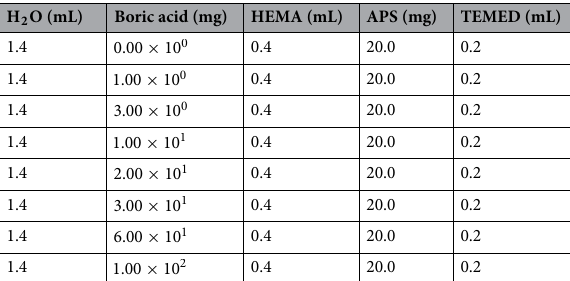
Table 2. Synthesis reaction conditions of poly(HEMA)